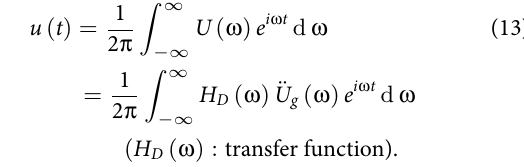
Frontiers in Built Environment |